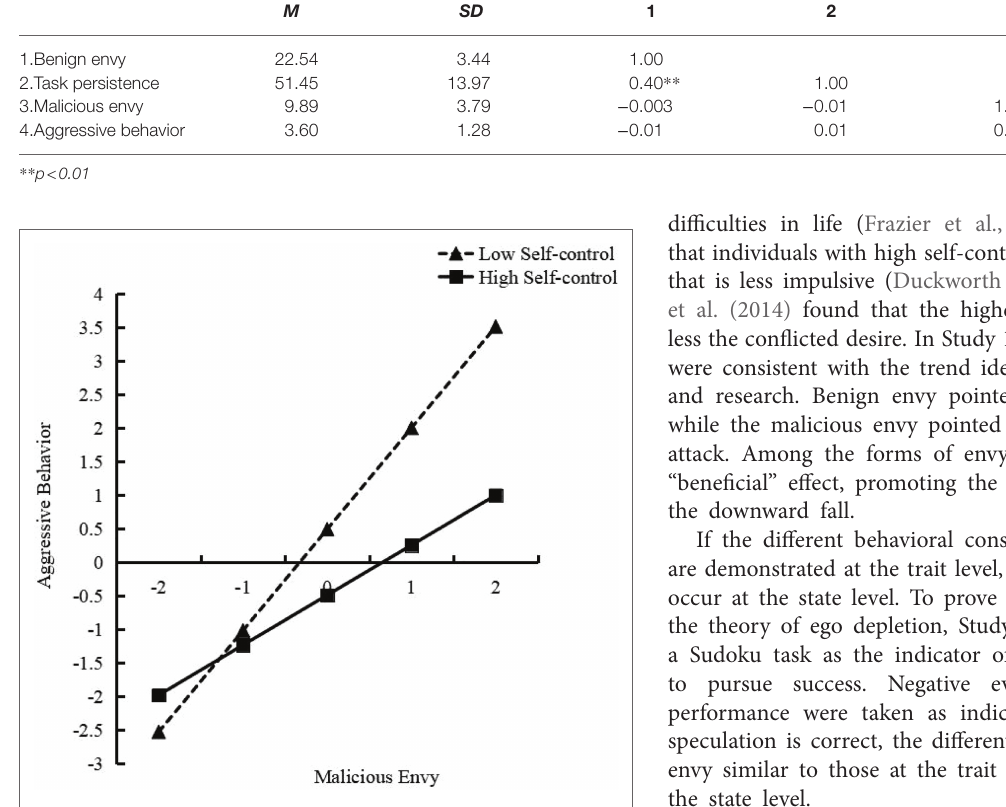
FIGURE 3 | The moderating effect of self-control on the relationship between malicious envy and aggressive